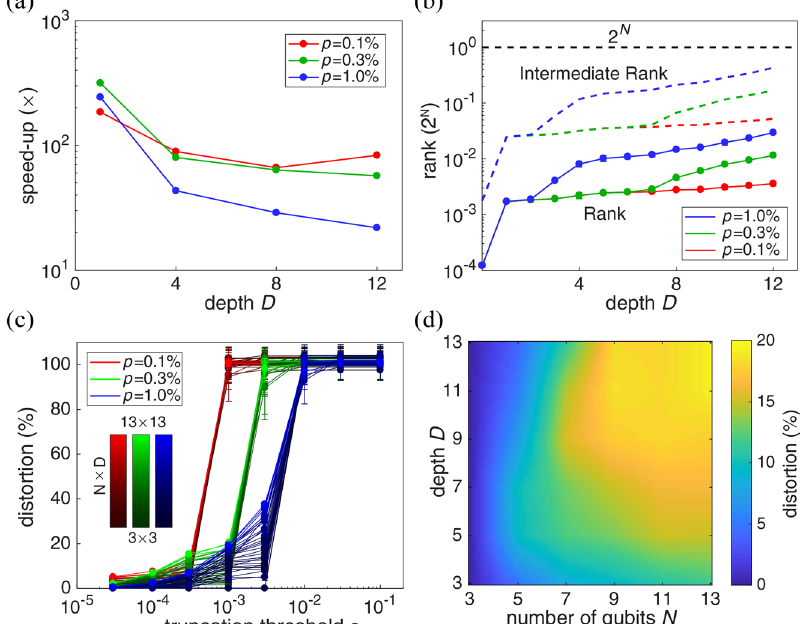
Fig. 5 Noise strength benchmarking under depolarizing noise. a Comparison of elapsed time of the LRET method for noise strength p = 0.1%, p = 0.3%, and p = 1.0% ( N = 13). b Comparison of V and V I for the LRET method for the three noise strengths ( N = 13). c Distortion as a function of circuit size and eigenvalue truncation threshold ϵ for the three noise strengths. d Distortion for p = 1% and ϵ = 10 − 3 as a function of N and D . In a , b , and d , the ratio ϵ / p stays constant. The error bars are standard-deviation-calculated across a set of